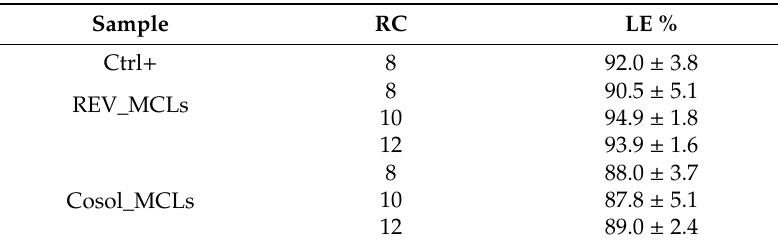
Table 6. Lipoplexation e ffi ciency calculated from Picogreen